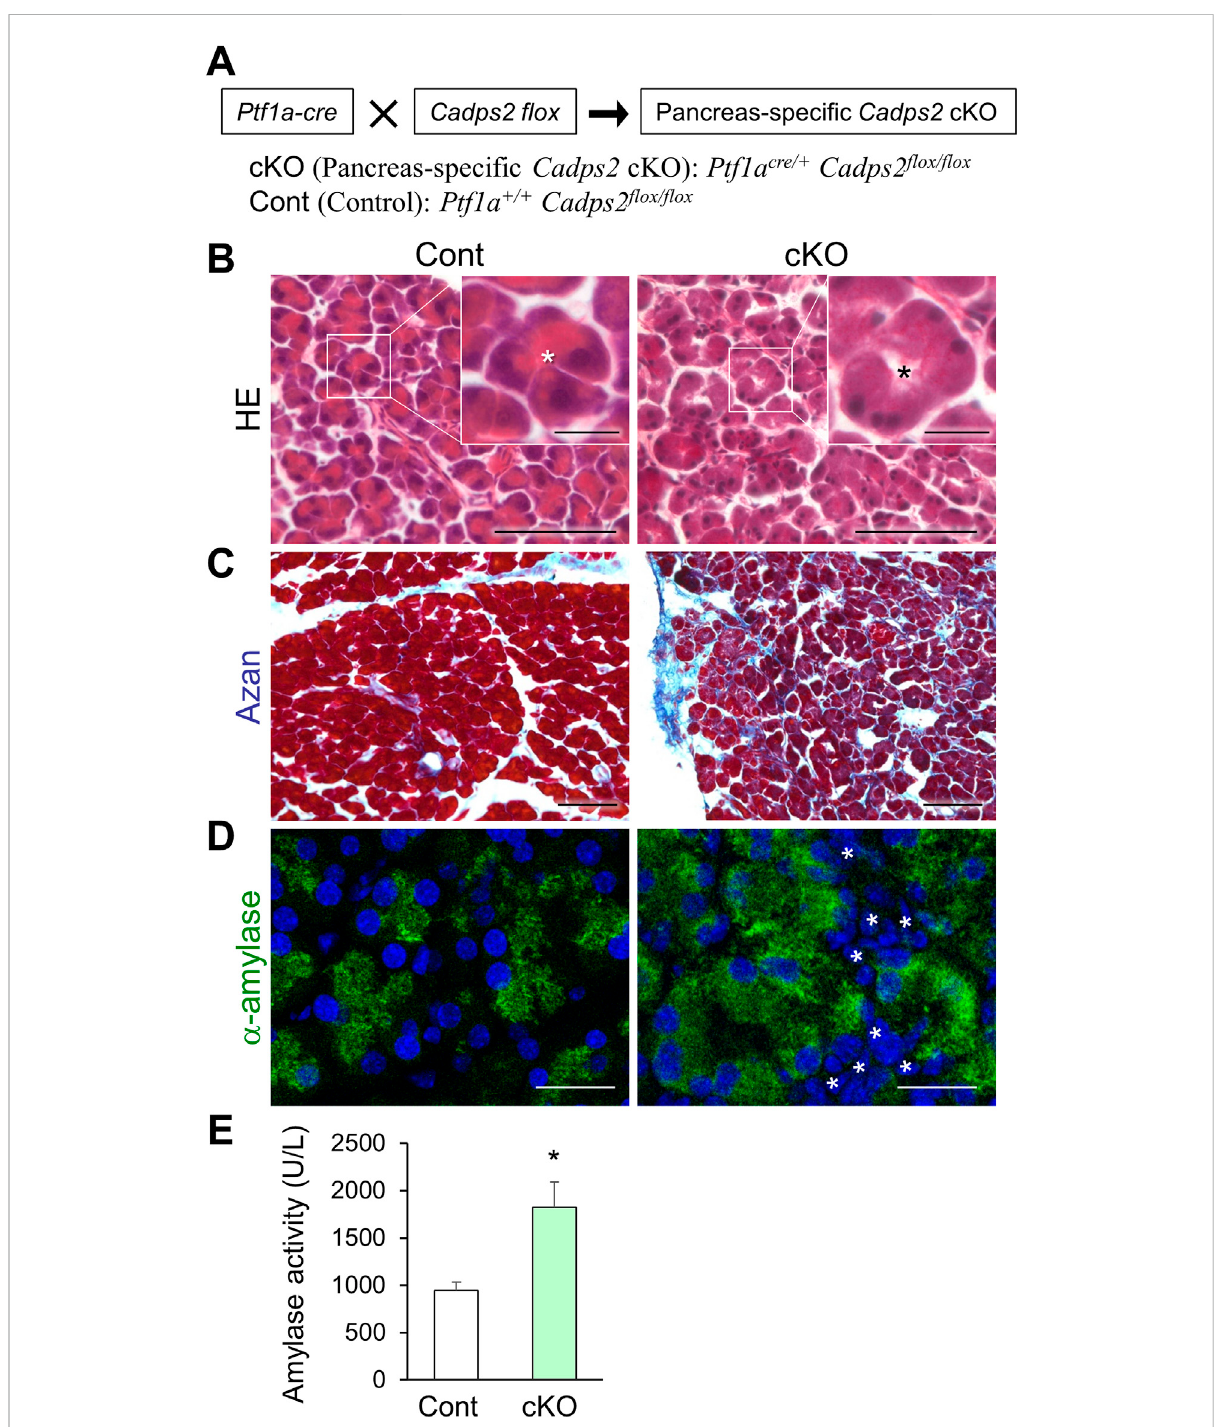
FIGURE 6 Pancreas-speci fi c Cadps2 -cKOmiceshowedsimilarcellularandbiochemicalphenotypesas Cadps2 -KOmice. (A) ,Pancreas-speci fi c Cadps2 - cKO ( Ptf1a cre/+ Cadps2 fl ox/ fl ox )mice weregenerated by crossing Cadps2 fl oxed mice (Fujima etal., 2021) with Ptf1a -driven Cre mice (Kawaguchi et al., 2002). Ptf1a +/+ Cadps2 fl ox/ fl ox mice were used as the control (Cont). (B) , Reduced basophilic hematoxylin signals in the pancreatic acinar cells of Cadps2 -cKO mice. HE-stained pancreatic sections of control and Cadps2 cKO mice at 15 weeks of age. The inset in the top right corner represents magni fi edimagesofthe areaindicated byasquare ineach image. Asterisks indicate theacinar lumen.The basophilic hematoxylin signals in the basolateral cytoplasm of WT acinar cells were reduced in cKO mouse acinar cells. Scale bars: 100 μ m; 20 μ m for inset images. (C) , Increased fi brosis in the pancreas of cKO mice. Azan-stained fi brotic collagen components ( blue ) in the pancreatic sections of control and Cadps2 cKO